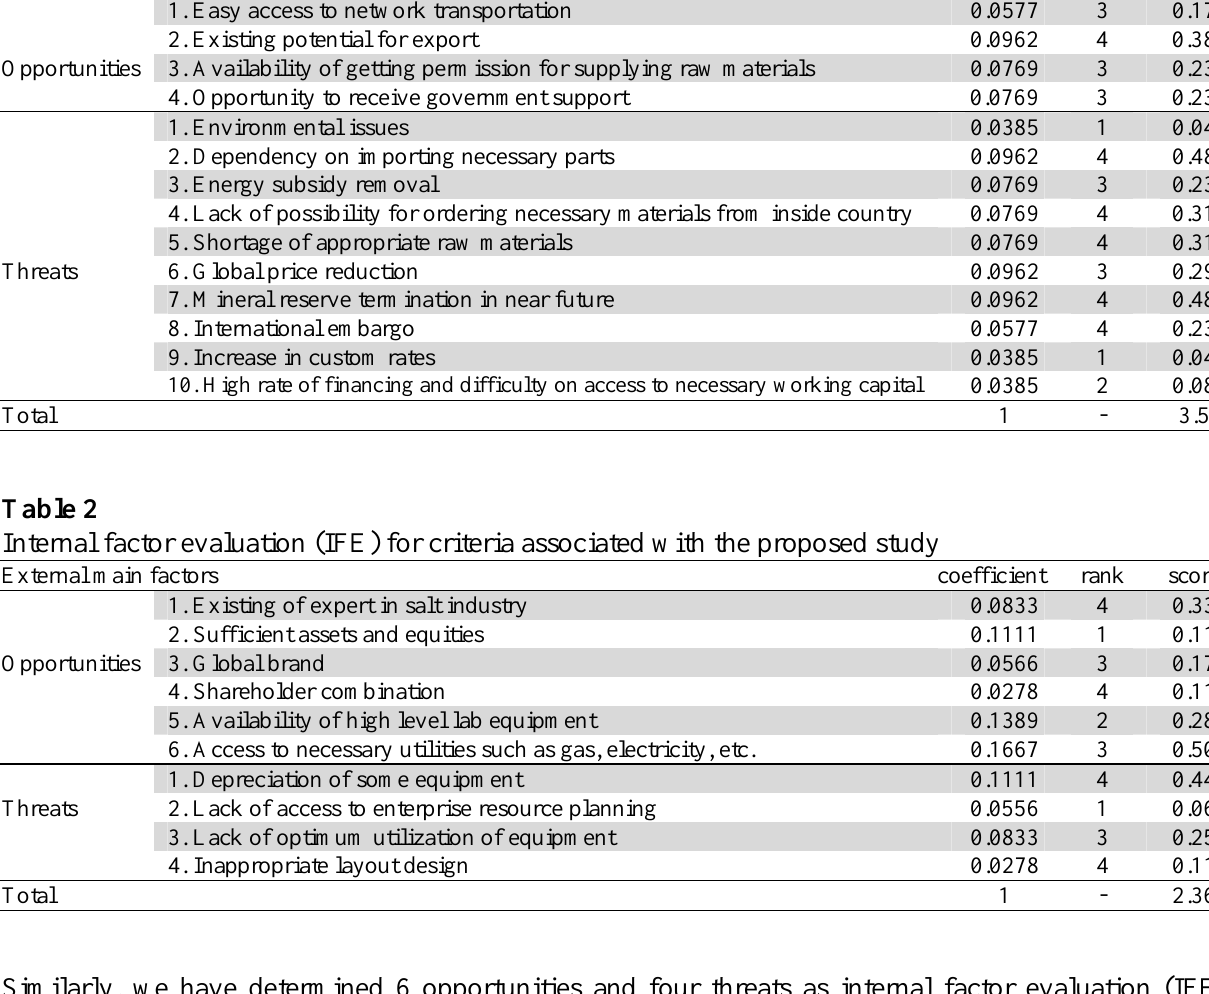
External factor evaluation (EFE) for criteria associated with the proposed study External main factors